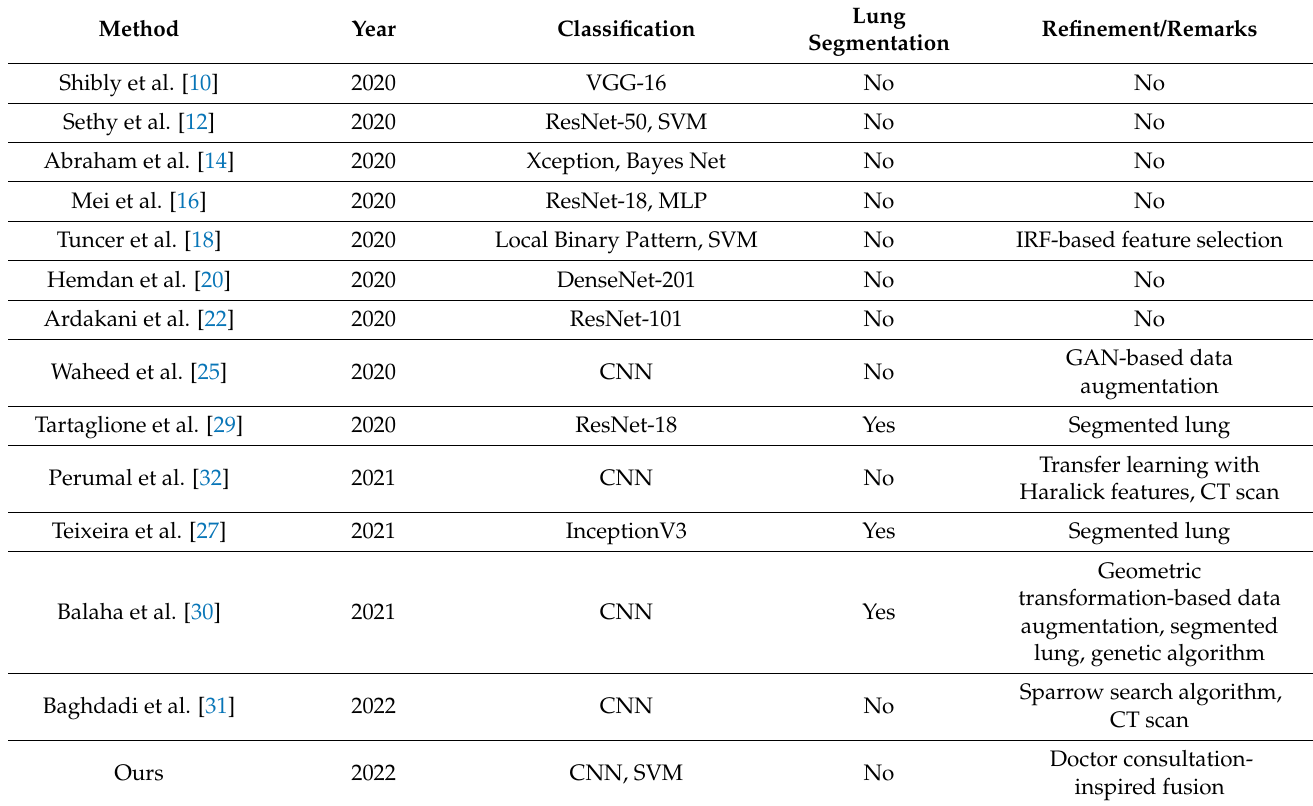
Table 1. Comparison of related